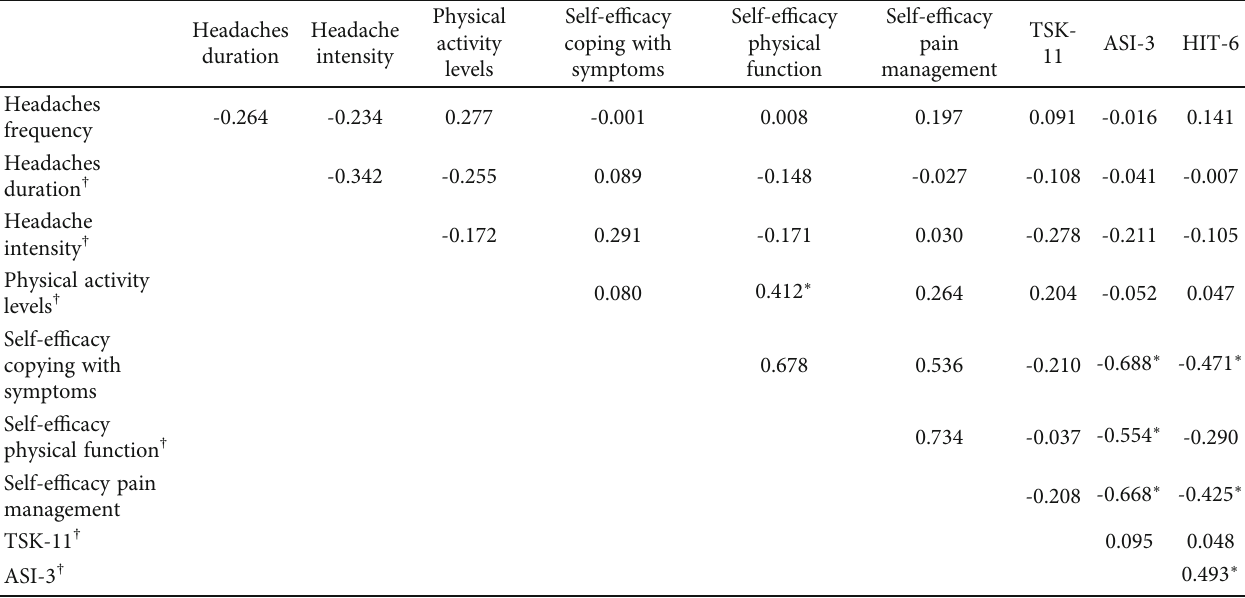
Table 2: Correlations between the continuous